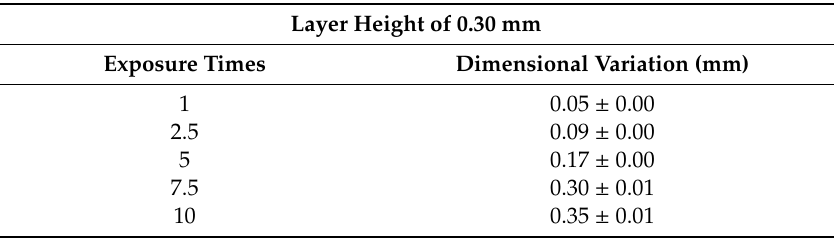
Table 6. Dimensional variation for each exposure time and layer height of 0.30 mm .